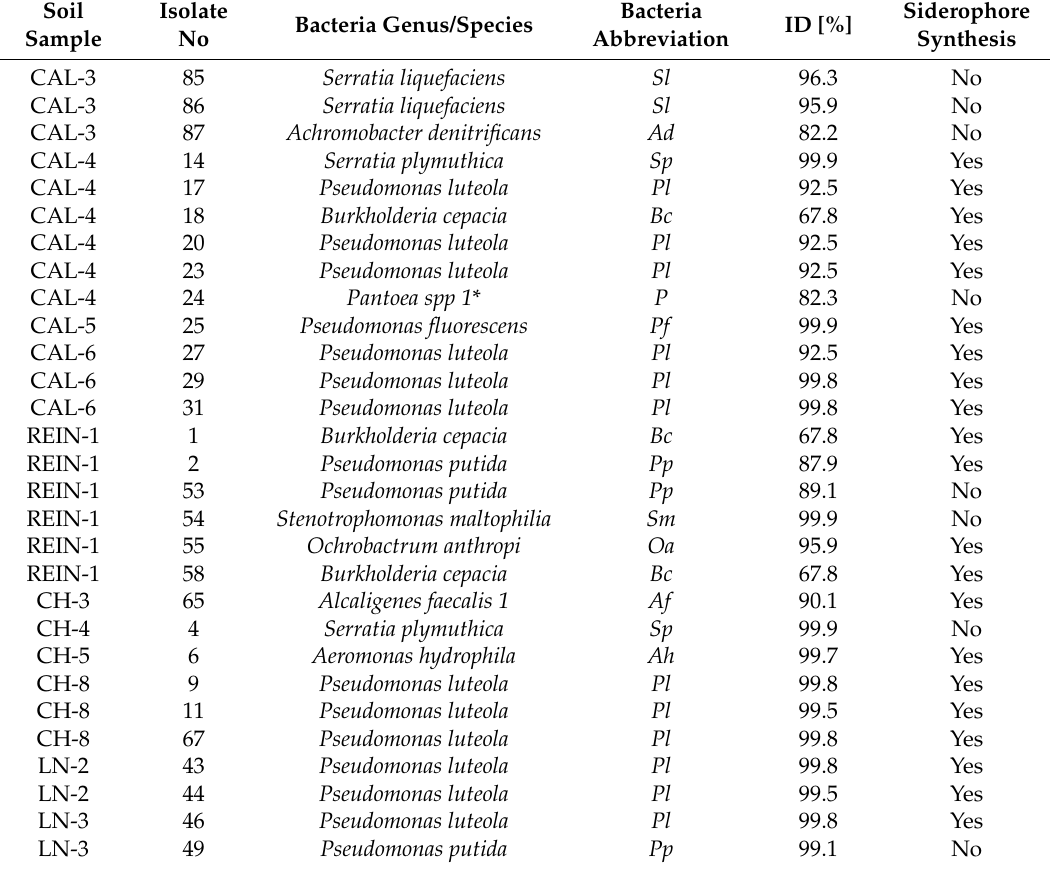
Table 1. Identification of strains according to the analytical profile index (API) tests and their ability in siderophore synthesis. All strains are Gram-negative, otherwise * shows Gram-positive